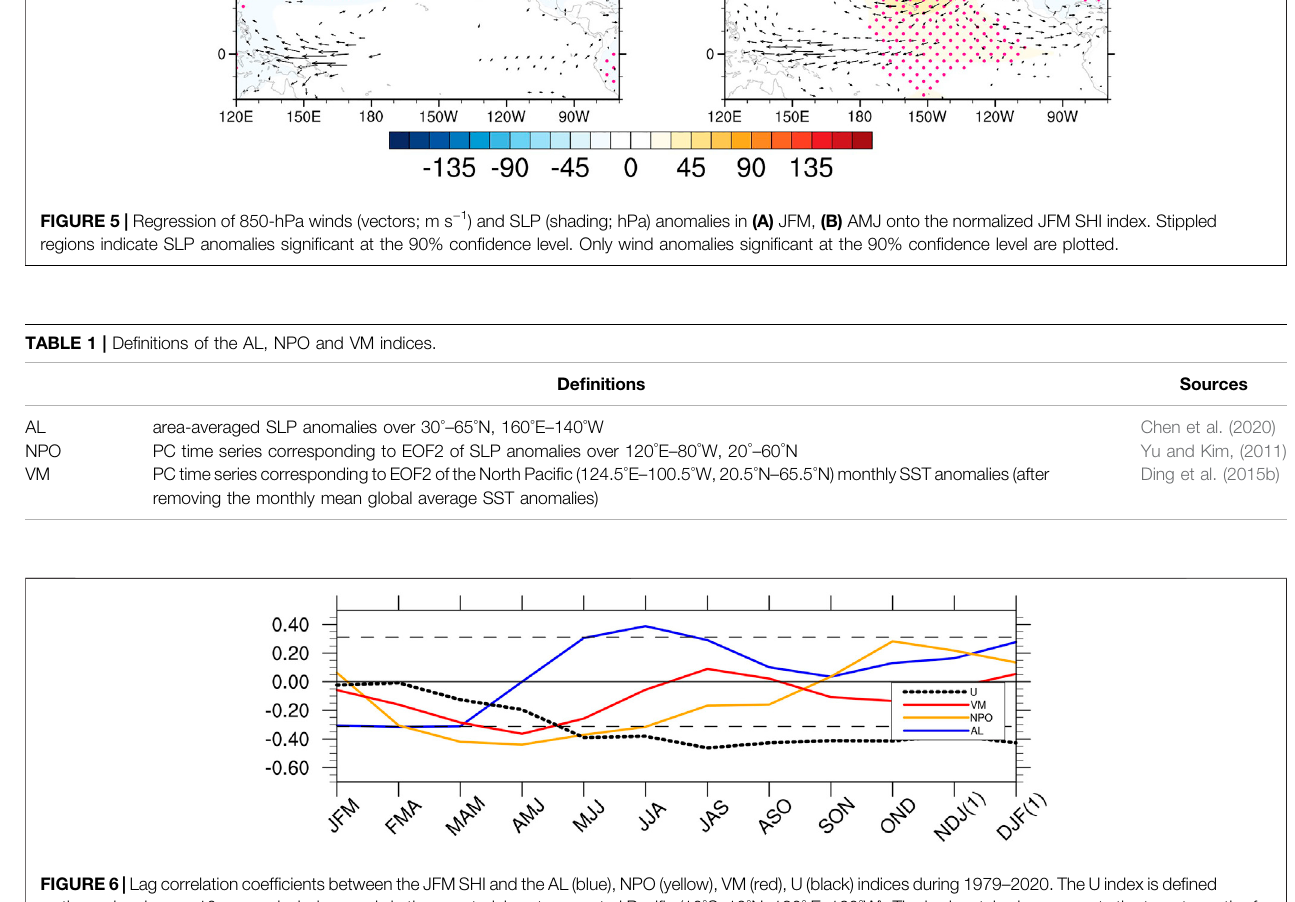
Frontiers in Earth Science |